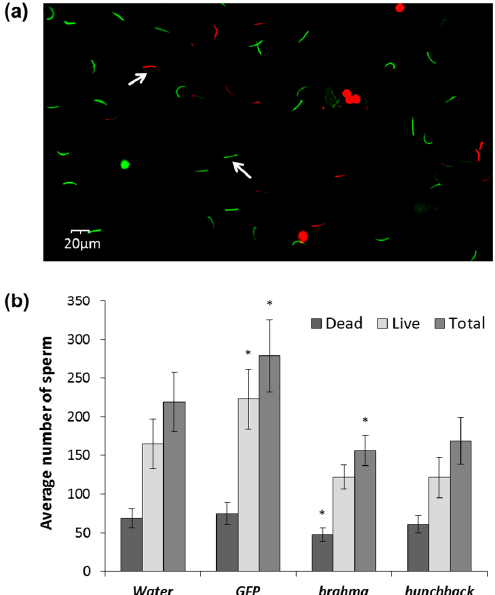
Figure 5. Sperm viability of D. v. virgifera males exposed to brahma ( brm ) and hunchback ( hb ) dsRNA: ( a ) sample composite digital image of live (green) and dead (red) sperm from half of a single field of view (10X); and ( b ) total number of sperm (live + dead) of males exposed four times to brm and hb dsRNA. Comparisons performed with Dunnett ′ s test (control group = water), * significance at p < 0.05.